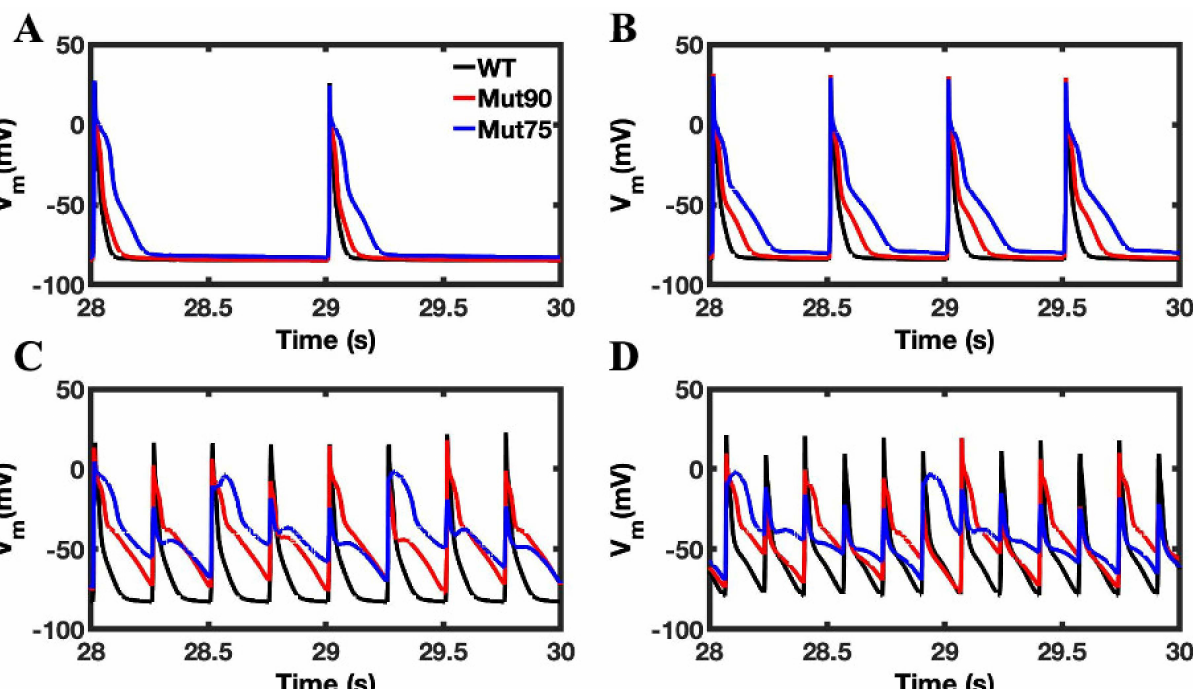
Figure 12. Transmembrane voltage in beta-adrenergic stimulated cardiac myocytes: ( A ) 1 Hz pacing, ( B ) 2 Hz pacing, ( C ) 4 Hz pacing, ( D ) 6 Hz pacing. The wild-type cardiac myocytes (black) show con- sistent morphology with increased pacing. The mutant simulations CDI (75% of transition rate—blue and 90% of transition rate—red) of the cardiac myocyte show that during pacing, the ability of mutant beta-adrenergic cardiac myocytes to repolarize is diminished and leads to arrhythmia. Shown are representative simulations out of six repeated simulations with different random number seed values in each case. The different simulation traces for each condition overlap at steady-state